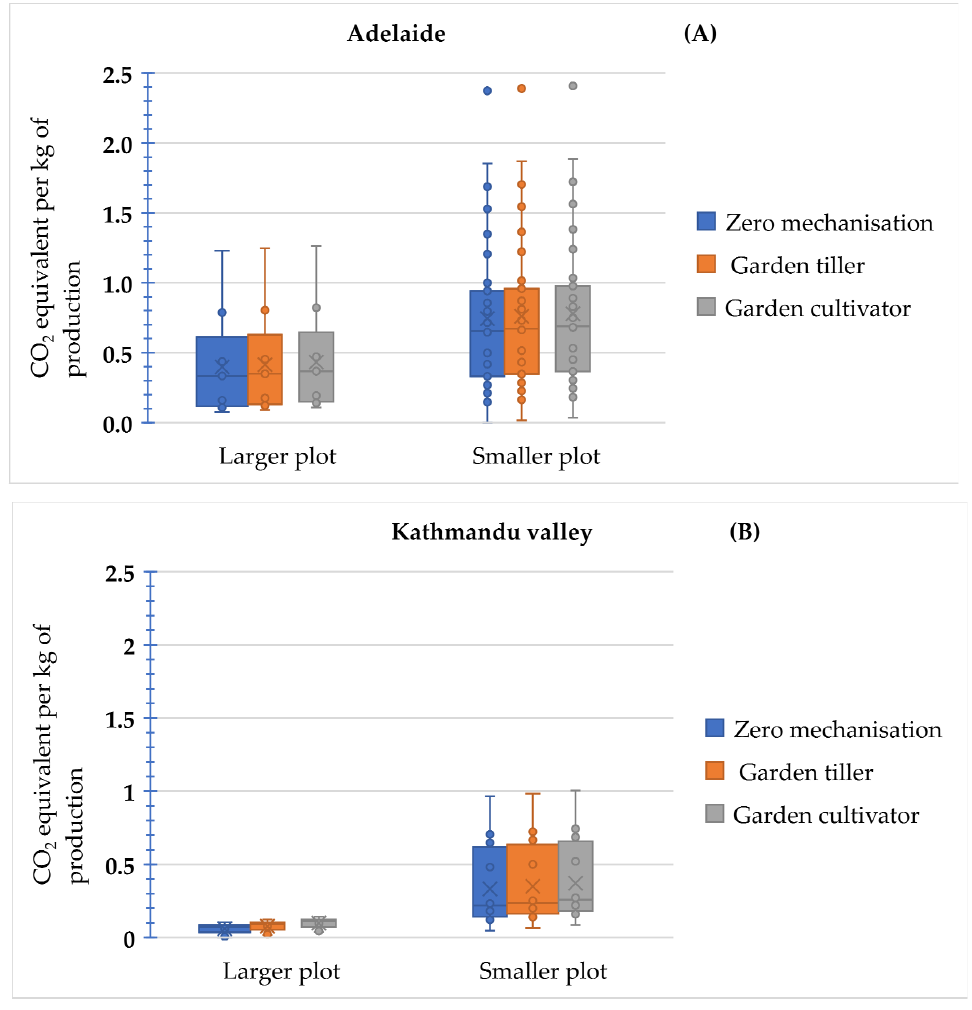
Figure 8. ( A , B ). Area-wise carbon dioxide emission calculation in Adelaide and Kathmandu Valley. The X marker represents the average value, the horizontal line marks the median, the box marks standard deviation, the extended lines (whiskers) mark the 5th and 95th percentiles, and the dots mark the outliers.